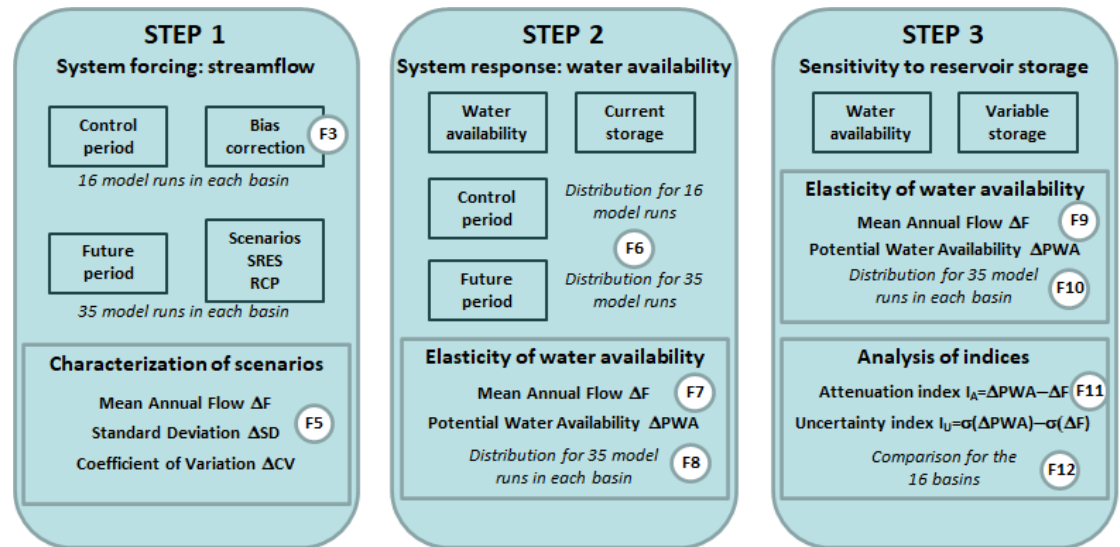
Figure 2. Main methodological steps followed in the analysis. White circles show the figures that illustrate results from each step.